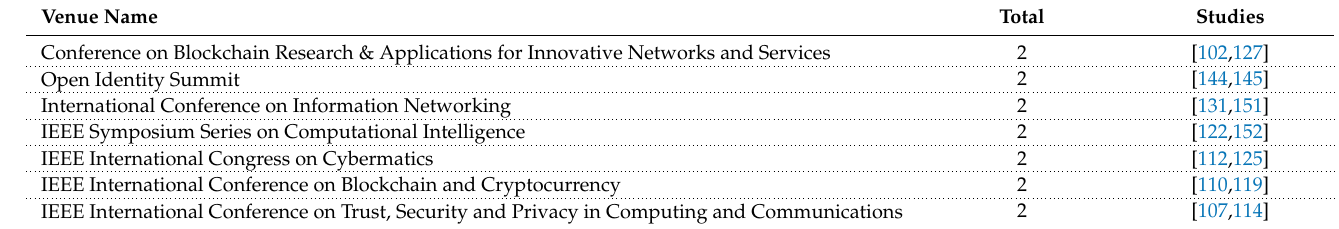
Table 10. Conferences, symposia and forums with multiple publications.